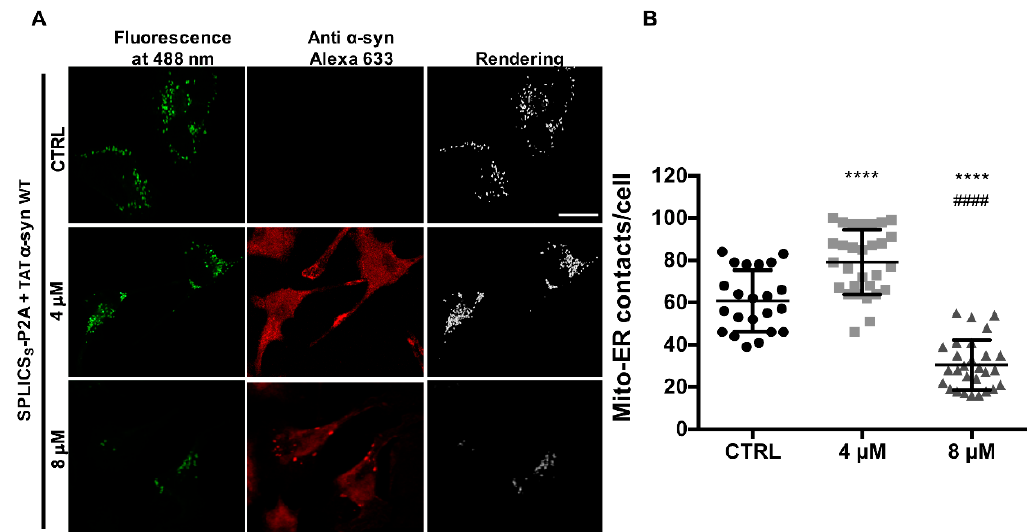
Figure 5. TAT-mediated delivery of α -syn affects ER-mitochondria contact sites in a dose-dependent manner. ( A ) HeLa cells were transfected with SPLICSs sensor to assess short-range ER-mitochondria associations and then incubated with the indicated doses of TAT WT α -syn. SPLICS S . Reconstitution of the fluorescent signal was observed upon 488 nm wavelength excitation in α -syn positive cells probed with an anti α -syn primary antibody and revealed by an Alexa 633 secondary antibody. The 3D rendering of the Z-stacks acquired for the SPLICS S probe is shown on the right. ( B ) Quantification of the ER-mitochondria contact sites/cell in the different conditions is shown as mean ± SD. **** vs. CTRL or #### vs. 4 μ M, p < 0.0001. One-way ANOVA test retrieved a p -value of 0.0001. Results are the mean ± SD obtained from at least two independent transfections, for multiparametric analysis a Dunnet’s post-test was applied.